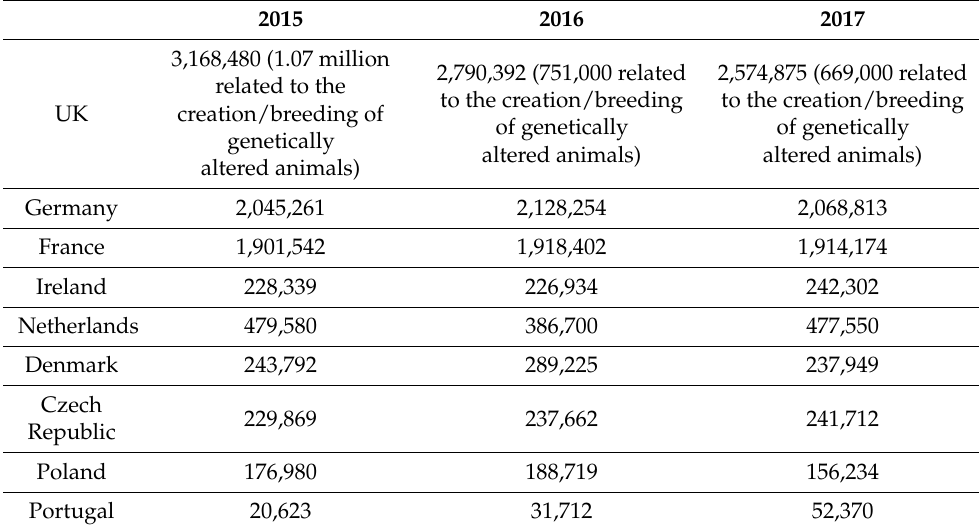
Table 3. Comparison of Total Number of Animals Used in Experiments across Selected Mem- ber States